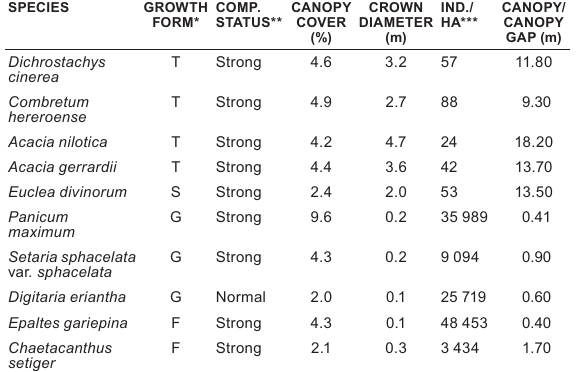
* T = Tree; DS = Dwarf shrub; G = Grass; F = Forb ** Competitor status *** Individuals per hectre